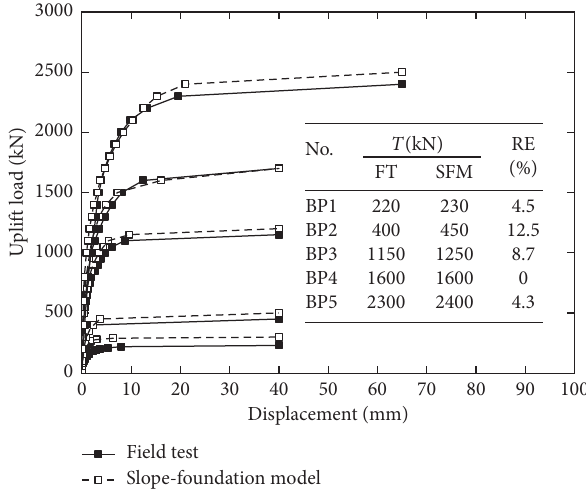
Figure 9: Calibration results between the numerical modeling and the field loading tests in Anhui site (RE means relative